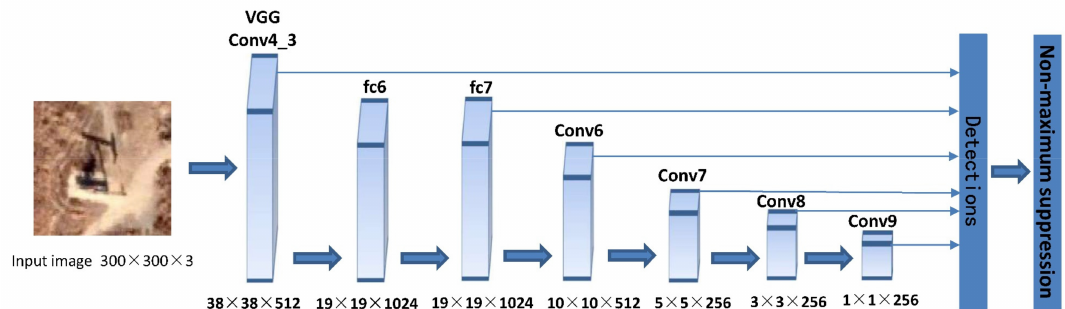
Figure 2. Layer architecture of the SSD